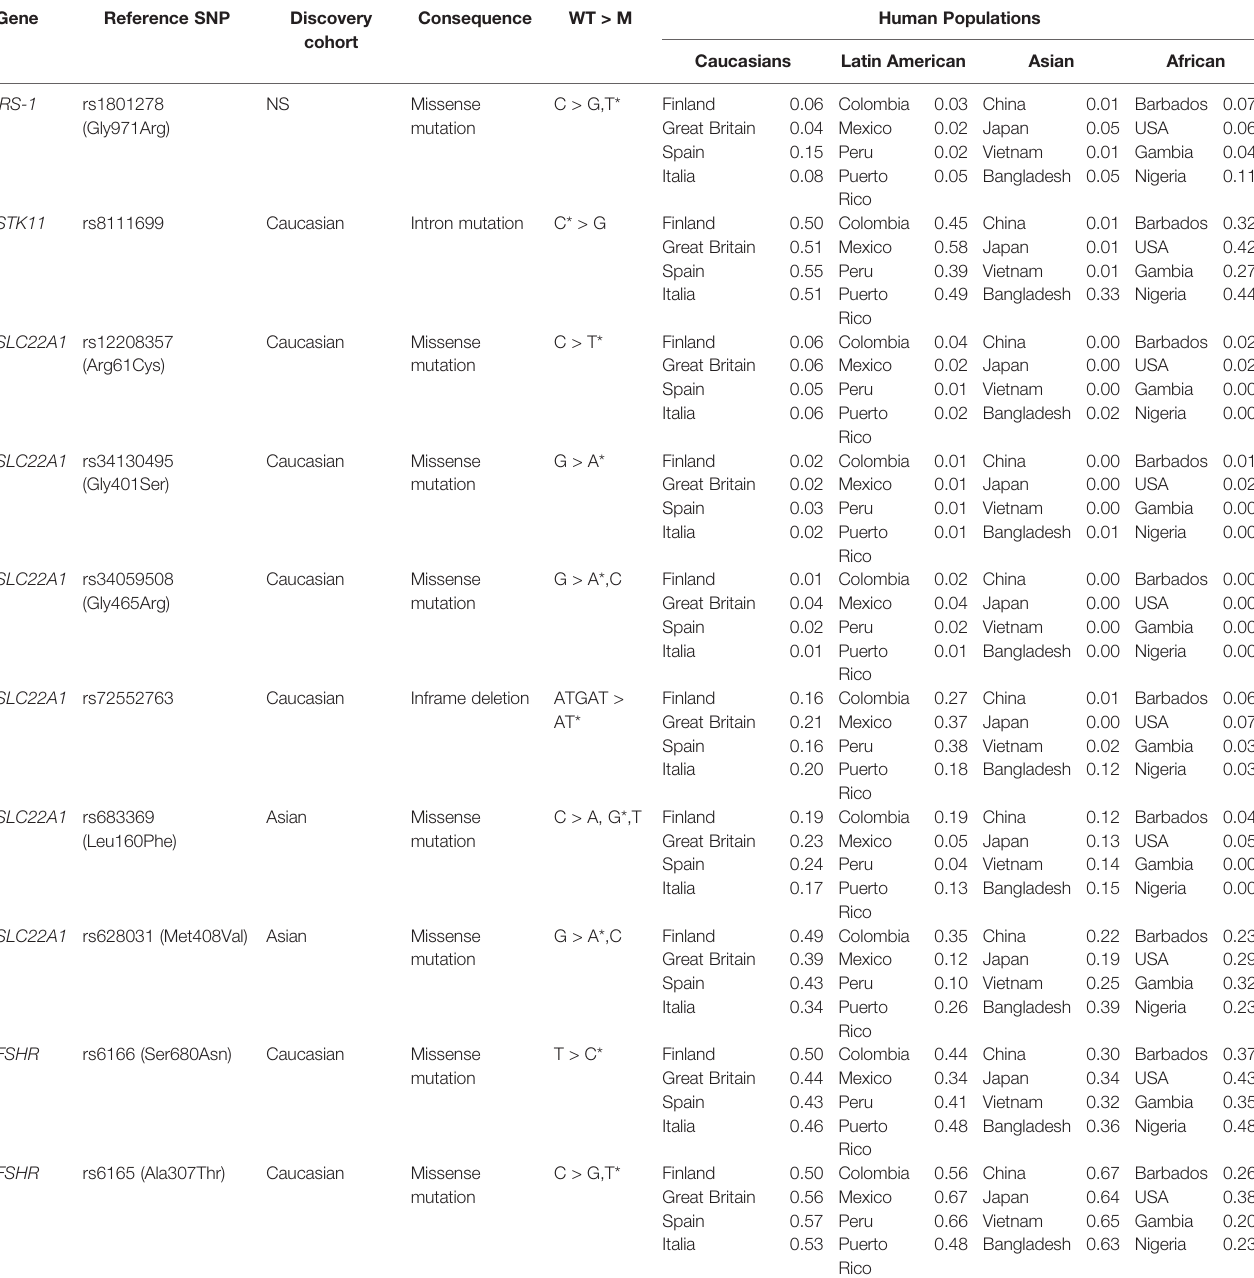
TABLE 7 | Allele frequencies for relevant genetic variants associated with PCOS treatment response in human populations worldwide. Gene Reference